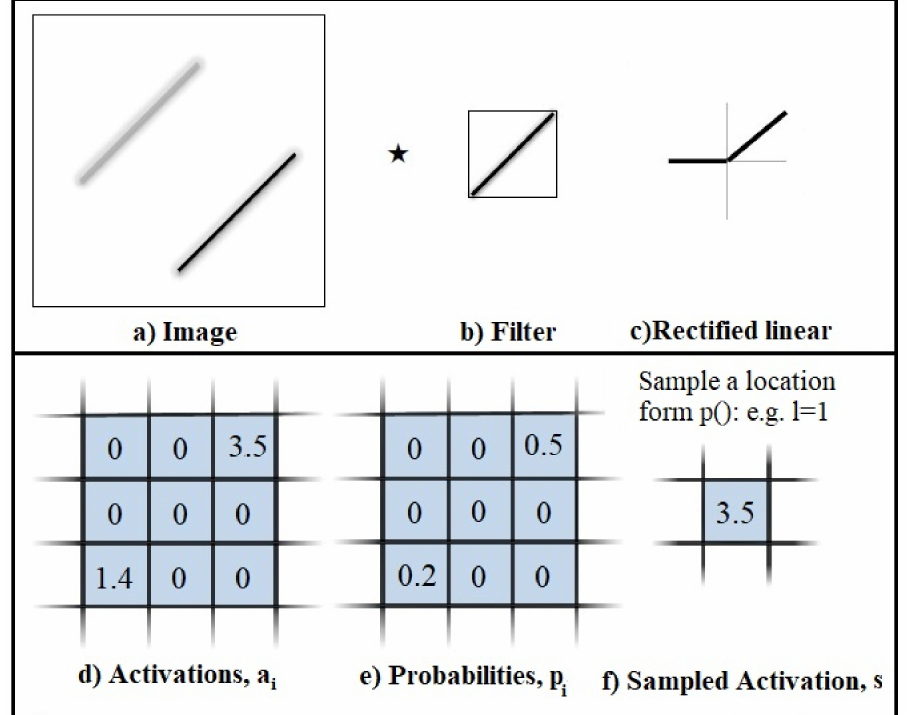
Figure 4. The example of random sampling for deep learning. ( a ) Image. ( b ) Filter. ( c ) Rectified linear. ( d ) Activation. ( e ) Probabilities. ( f ) Sampled